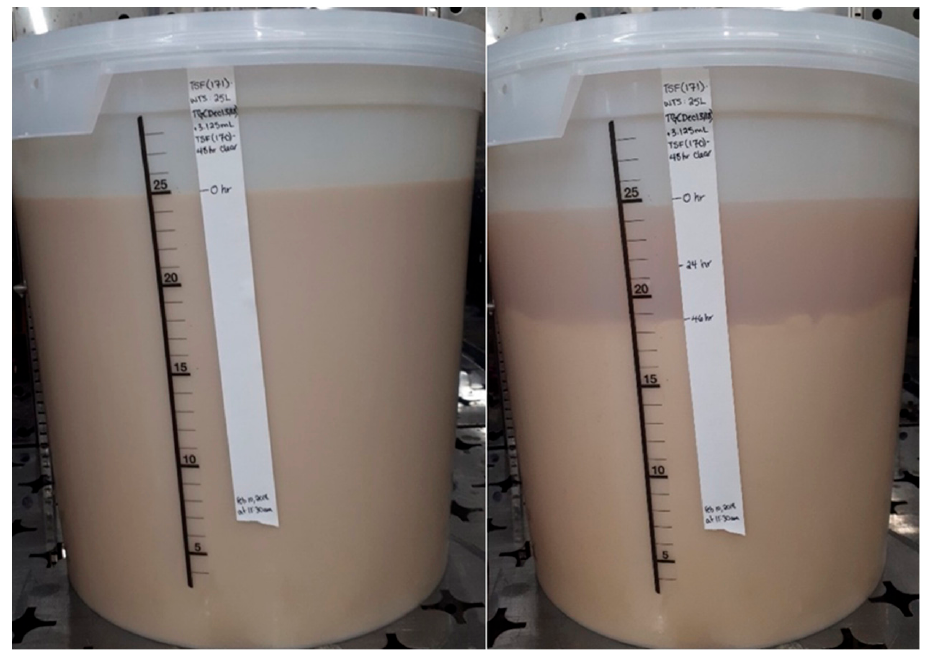
Figure 5. Wheat thin stillage before ( left ) and after ( right ) 48 h of secondary fermentation by lactic acid bacteria. The initially homogenous solution separates into an upper layer composed of, mostly, clear liquid and a protein rich slurry in the bottom layer.